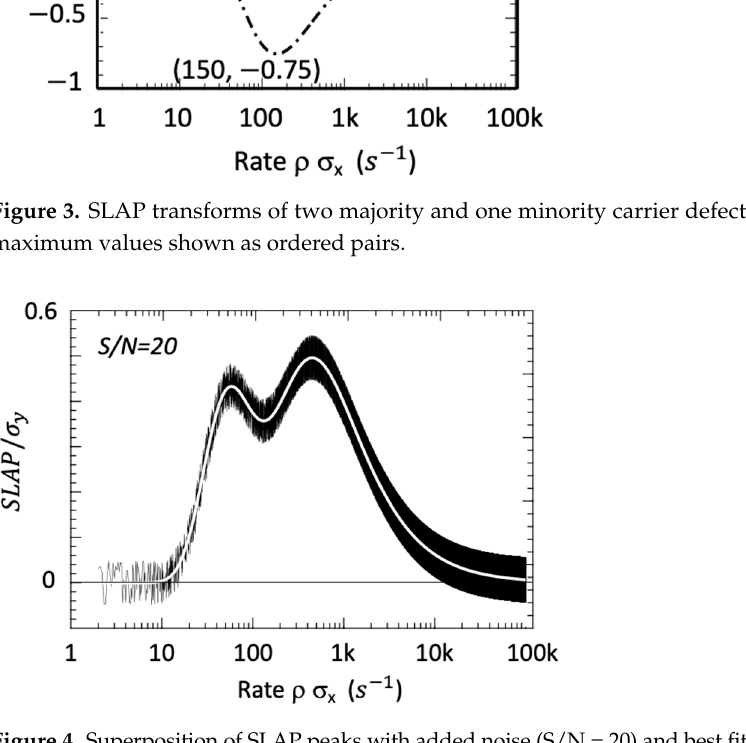
Figure 4. Superposition of SLAP peaks with added noise (S/N = 20) and best fit assuming three defects.